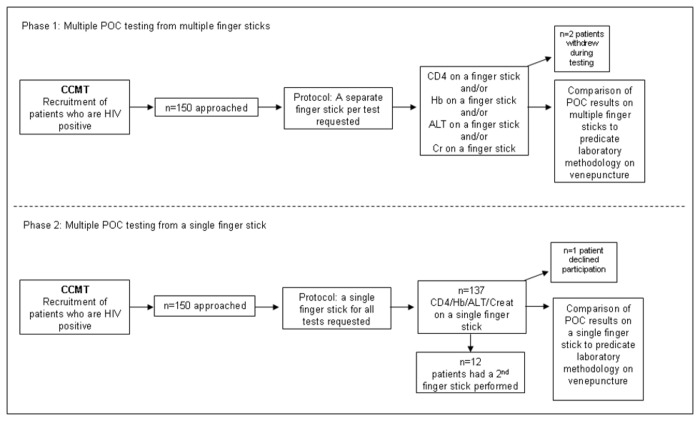
Schematic of study design.